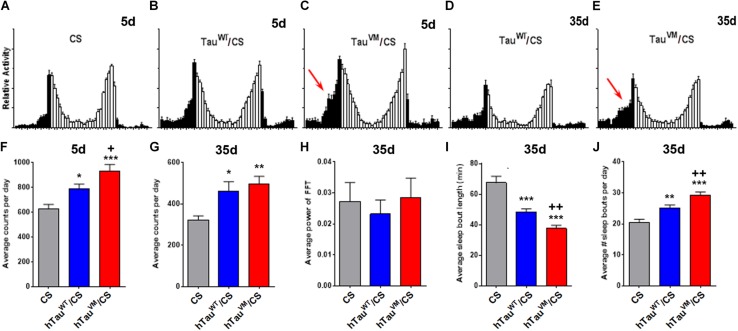
(A–E) Activity patterns show increased activity toward the end of the night (black bars) in 5- and 35-day-old hTauV337M/CS (arrows in C,E). (F) Counting the activity bouts per day shows an increase in 5-day-old hTauWT/CS and hTauV337M/CS compared to CS (asterisks) but hTauV337M/CS is also significantly more active than hTauWT/CS (plus sign). (G) At 35-day hTauWT/CS and hTauV337M/CS are more active than CS but no significant difference is found between hTauWT/CS and hTauV337M/CS. (H) Behavioral rhythmicity is not altered in hTauWT/CS or hTauV337M/CS. (I,J) Sleep is fragmented in 35-day-old hTauWT/CS and hTauV337M/CS compared to CS but hTauV337M/CS also shows significantly shorter and more sleep bouts than hTauWT/CS. * one-way ANOVA with Dunnett’s Post Test comparing the hTau/CS lines to CS. +Student’s t-test comparing hTauWT/CS and hTauV337M/CS. n > 22. *p < 0.05, **p < 0.01, ***p < 0.001, +p < 0.05, ++p < 0.01.